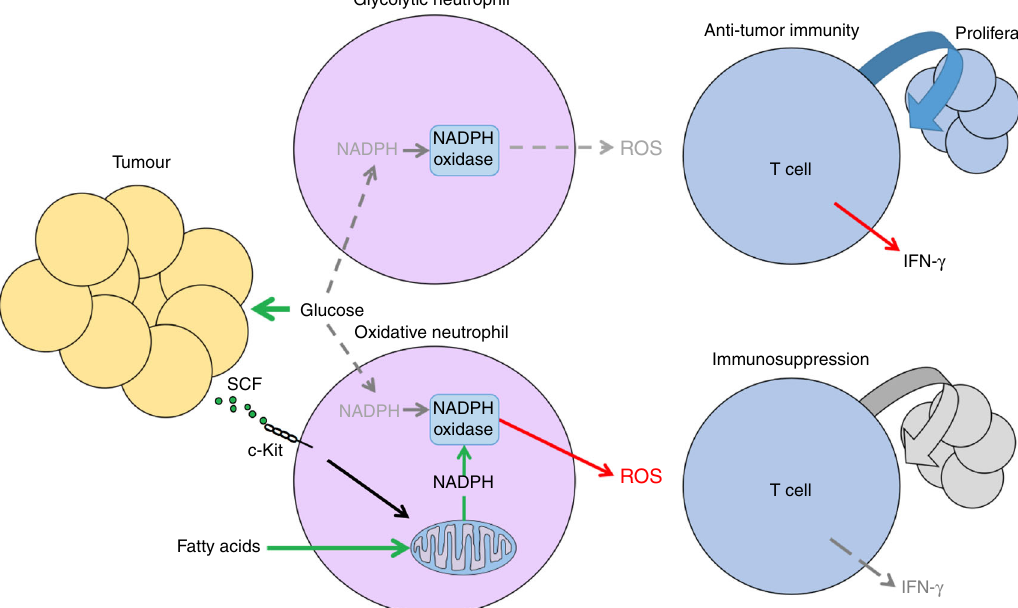
Fig. 8 Tumours promote metabolically adapted suppressive neutrophils. Neutrophils produce ROS which is capable of disrupting CD4 + T cell viability and function in the tumour microenvironment. Glycolytic neutrophils rely on glucose to maintain production of ROS and thusly in the glucose-deprived tumour- microenvironment (TME) glycolytic neutrophil activity is predicted to be limited. However, 4T1 tumours elicit mitochondria rich oxidative-neutrophils through aberrant stem cell factor (SCF)/c-Kit signalling. Oxidative neutrophils are able to maintain NADPH-oxidase dependent ROS production in the absence of glucose utilisation through fatty acid dependent mitochondrial function to maintain NADPH levels. This c-Kit dependent mechanism allows neutrophils to overcome nutrient limitations and suppress anti-tumour immunity in the glucose deprived